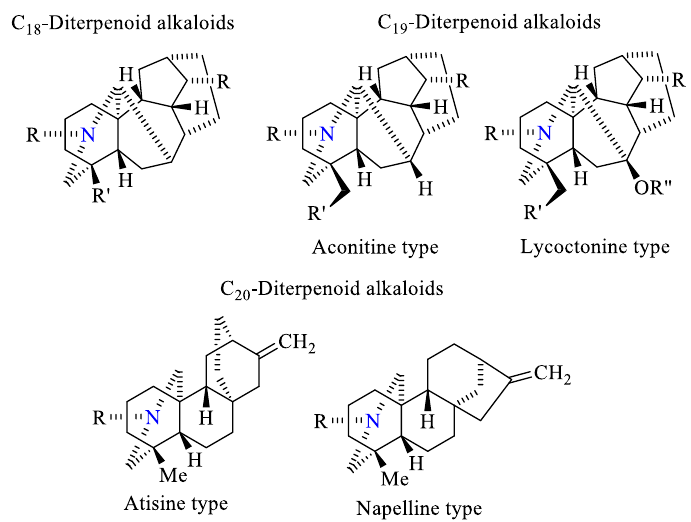
Figure 5. The examples of diterpene alkaloids.